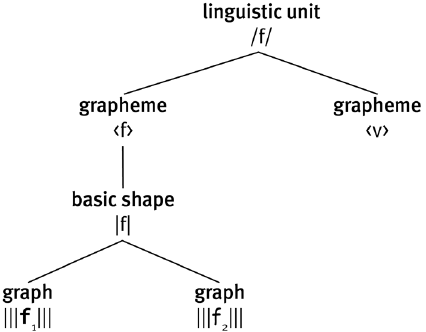
Figure 2: Hierarchy of units of writing systems illustrated by the graphematic representation of /f/ in